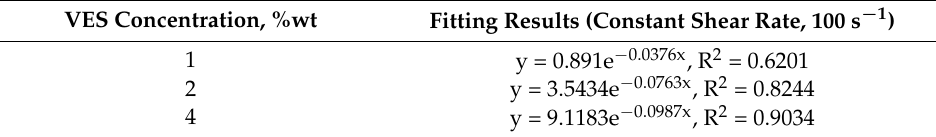
Figure 2. Effect of VES concentrations on fluid viscosity (1.44% HCl and 1% CaCl 2 ). Table 2. Fitting results of rheological behavior at different VES concentration. VES Concentration,